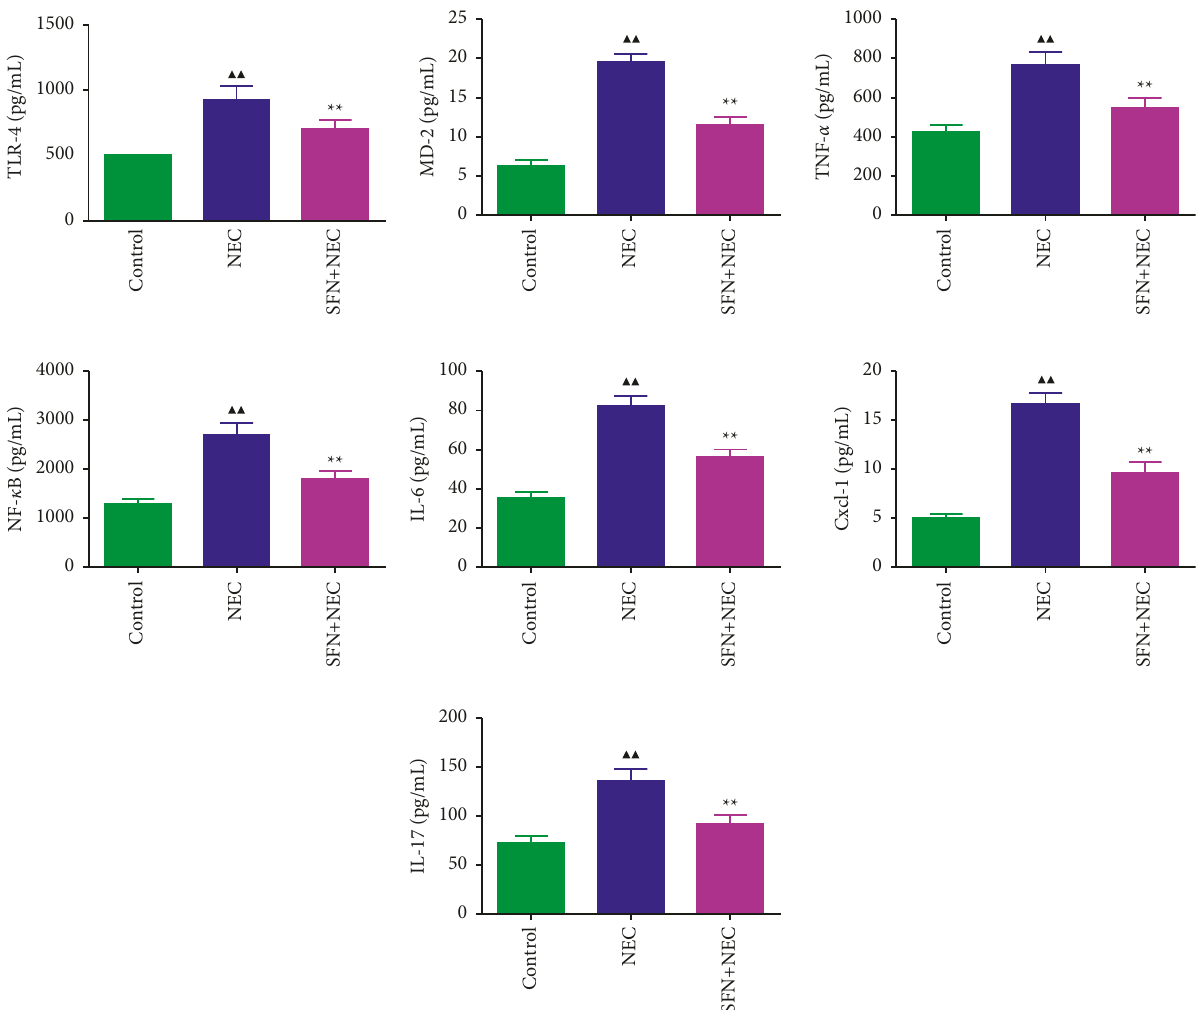
Figure 2: Changes of TLR4, MD-2, TNF- α , NF- κ B, IL-6, CXCL1, and IL-17 contents in the serum of NEC mice. NEC, necrotizing enterocolitis; SFN, sulforaphane. Compared with the control group, ▲ P < 0 . 05, ▲▲ P < 0 . 01; compared with the NEC group, ★ P < 0 . 05, ★★ P < 0 . 01. Data represent the mean ± SD, n �